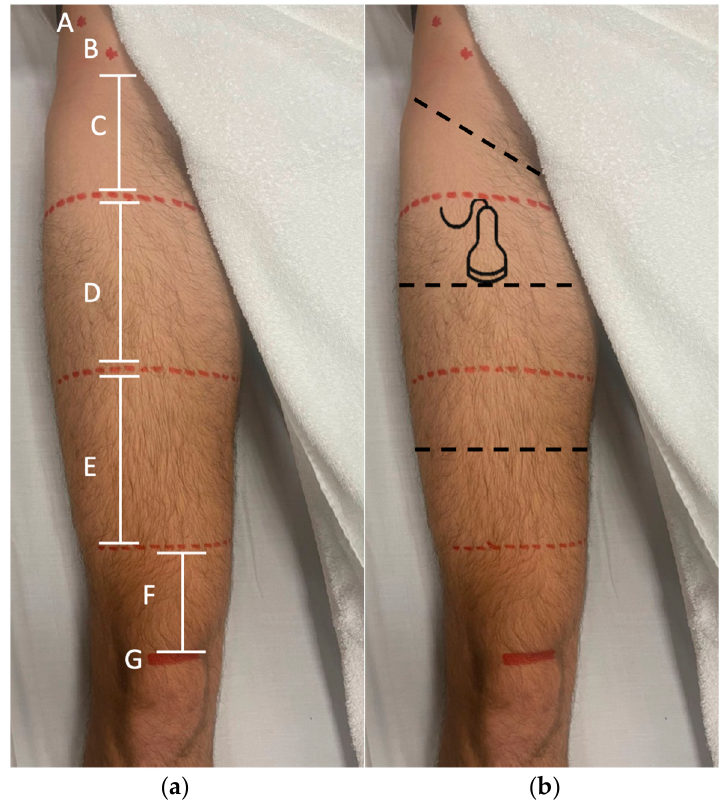
Figure 1. Landmarks of the measurements. ( a ) The RF was divided into three equal parts, ASIS (A), AIIS (B), proximal third perimeter (C), medial third perimeter (D), distal third perimeter (E), quadriceps tendon length (F), superior pole of the patella (G). ( b ) The dotted black line in the middle of the division of the thirds is where the perimetry and RUSI evaluation of the RF was performed. Participants held the contraction for 3 s after which they were asked to relax as fast as possible. Three consecutive measurements were performed with 2 min rest in between to avoid fatigue (Figure 2).